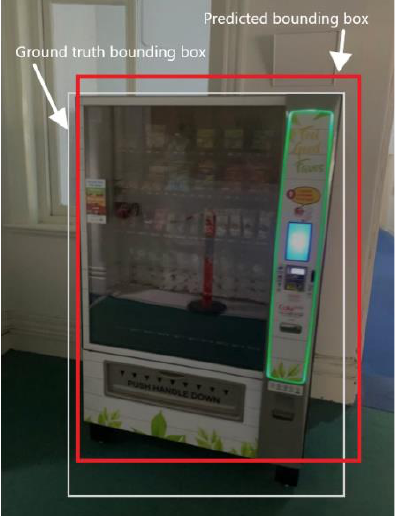
Figure 5. An example of vending machine detection in an image. The ground truth bounding box is drawn in white and the predicted bounding box is drawn in red.